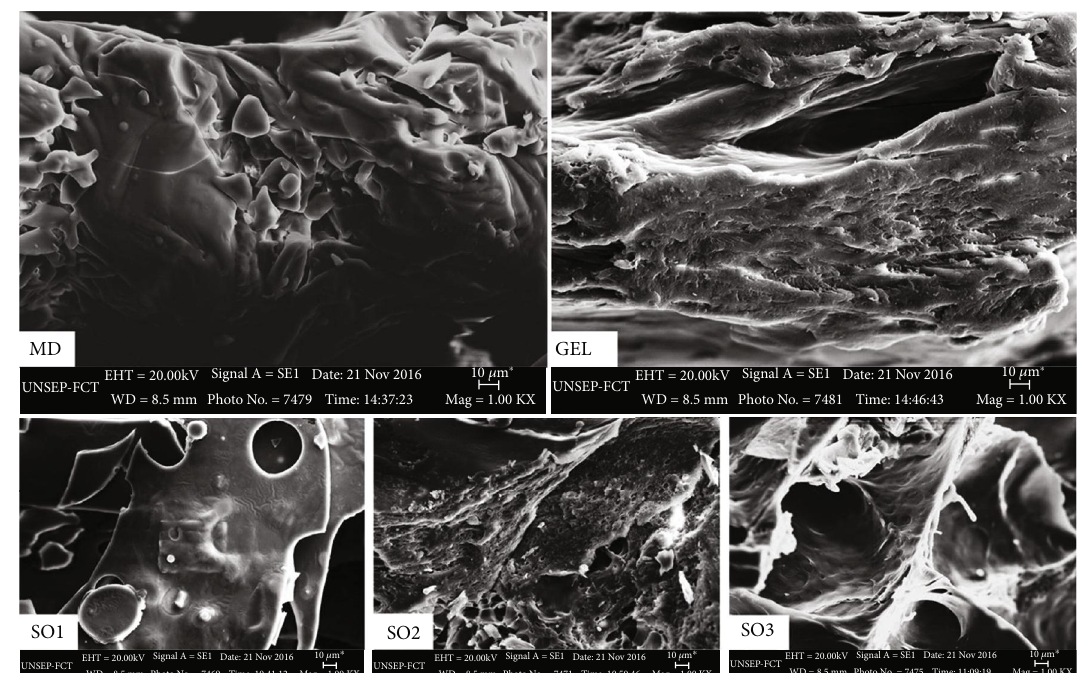
Figure 35: SEM micrographs of the isolated wall materials, maltodextrin (MD) and gelatin (GEL), and sweet orange essential oil microencapsulated systems (SO1, SO2, and SO3). SO1: contains only MD; SO2: contains MD and GEL at a ratio of 2:1; and SO3: contains MD and GEL at a ratio of 1 :1 [111].